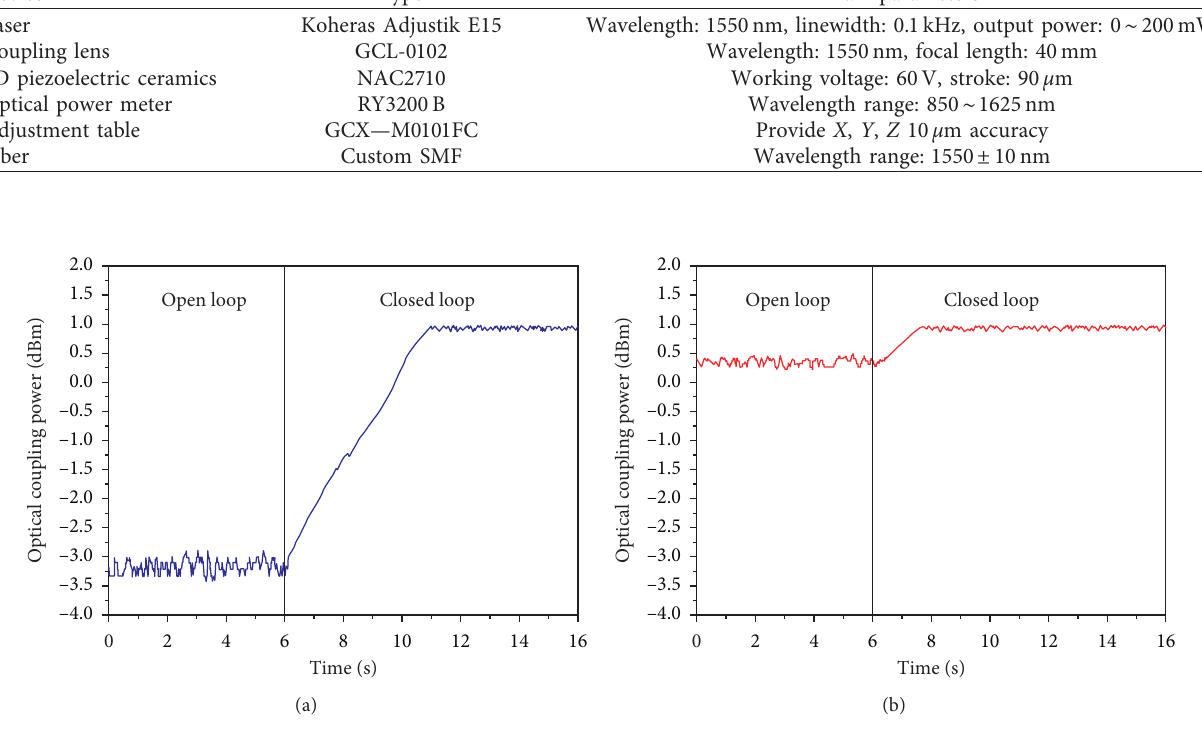
Figure 8: (a) Initial power of − 3.2dBm SMF-coupled optical power versus the time curve. (b) Initial power of 0.4dBm SMF-coupled optical power versus the time curve.